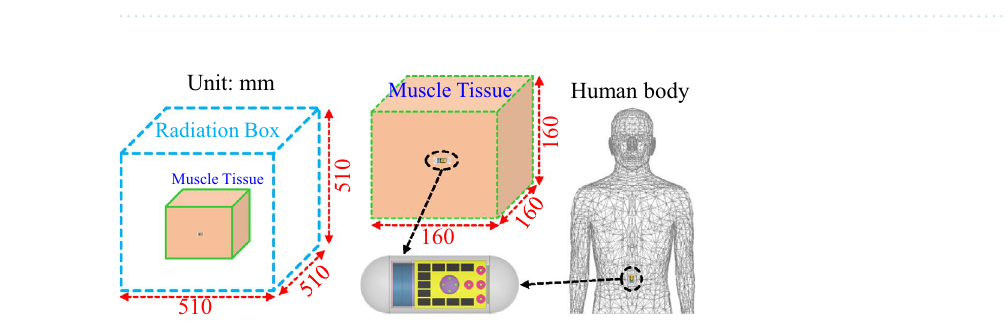
Figure 2. Schematic of the suggested MIMO antenna configuration ( a ) Top view, ( b ) bottom view, ( c ) 3D exploded view, and ( d ) side view.